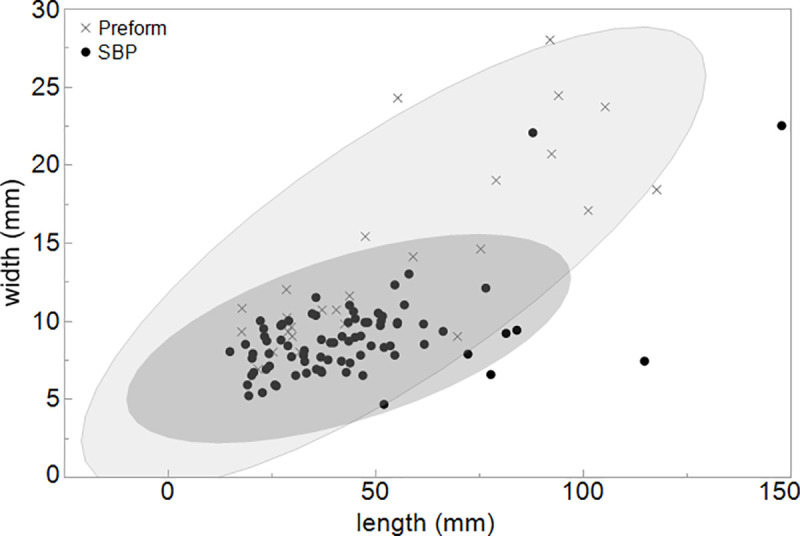
Length and width of all SBPs and preforms with 95% confidence interval.